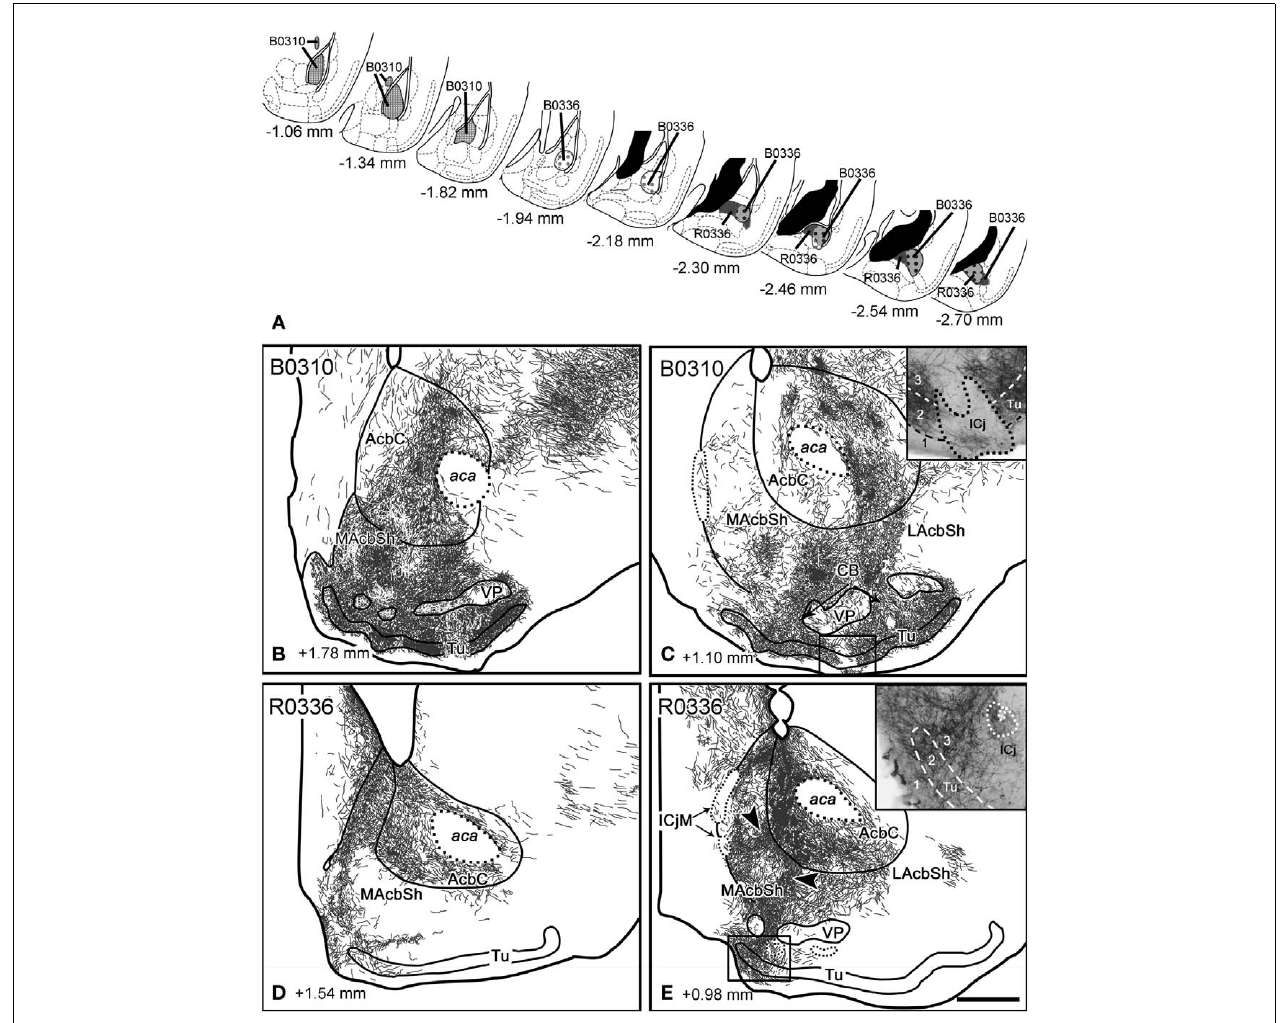
theTu through the CB. Labeling in theTu occupies layers 2 and 3, whereas layer 1 is virtually free of labeling [inset in (C) ]. (D,E) Anterograde labeling in the ventral striatum after injection R0336, which involved a large portion of the Bp. Labeling in the core of the Acb apparently shows continuity with the one in MAcbSh [see arrowheads in (E) ] and, through it, with the labeling in the CB and medialTu. labeling in theTu occupies not only layers 2 and 3 but also deep layer 1 [inset in (E) ]. For abbreviations, see list. Scale bar in (E) = 400 μ m, valid for the whole